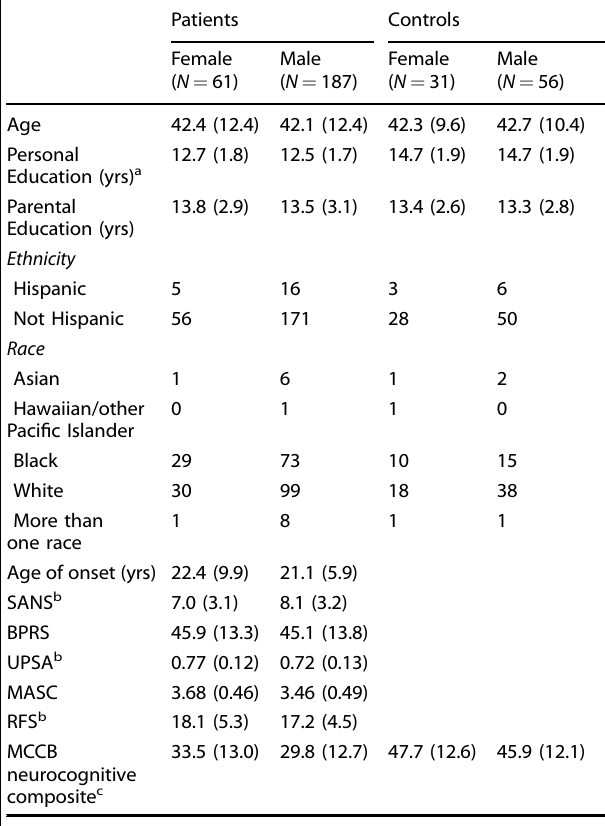
Table 1. Demographic and clinical